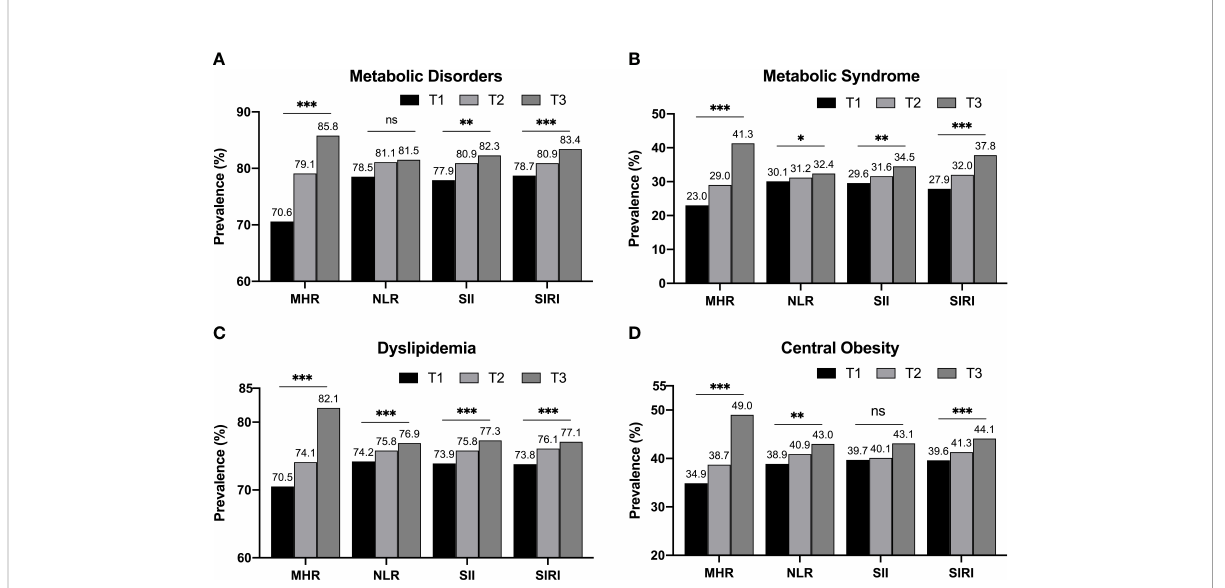
FIGURE 2 The prevalence of metabolic diseases in different in fl ammatory indicators grouped by tertiles. Regardless of the total MetD (A) or its detailed components, such as MetS (B) , dyslipidemia (C) , and central obesity (D) , they all showed a gradually increasing tendency with each tertile increment of various four in fl ammatory indicators. Statistical signi fi cance was de fi ned under two-tailed condition. *p < 0.05; **p < 0.01; ***p < 0.001; ns, no signi fi